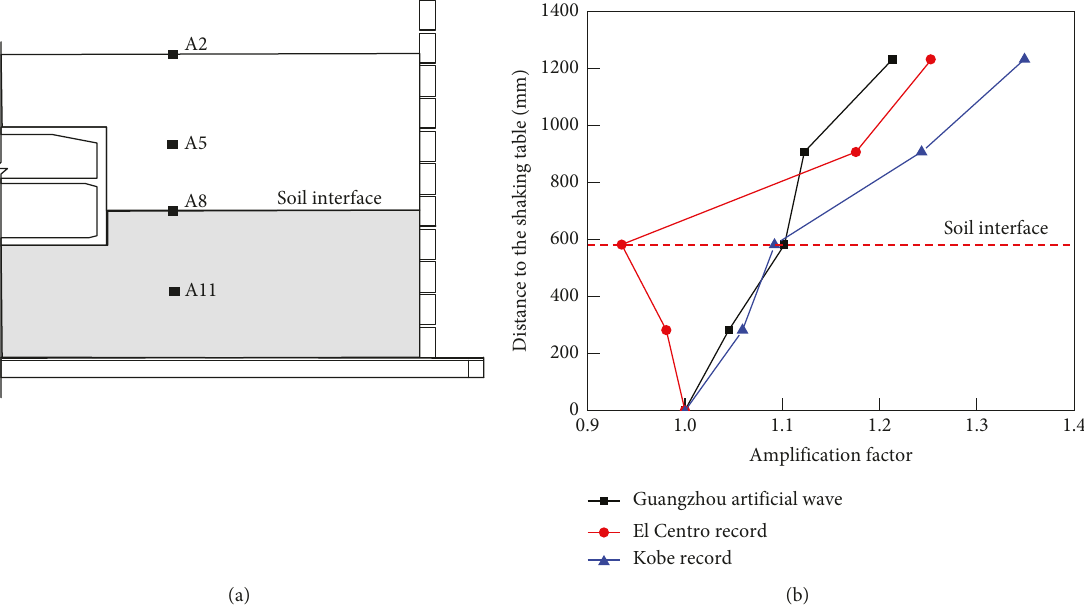
Figure 12: Peak acceleration amplification factor with the model soil depth in cases amplitude increased. However, the increment of the tensile Figure 18. For each component of the model structure, it is strain amplitude in the support region was larger than that in evident that the tensile strain amplitude in the support the midspan region, manifesting the irreversible de- region was larger than that in the midspan region. It is formation firstly occurring in the support region. Under the because that the support region of the large-span and col- input acceleration amplitude of 0.80 g, the largest tensile umn-free station bears much more force as the span in- strain amplitude of 130.2 με appeared in the support region creases greater than that of the conventional station, of the roof slab, followed by 100 με that appeared in the resulting in a larger tensile strain in the support region bottom support region of the lateral wall. In addition, the during the seismic wave. Nevertheless, the tensile strain tensile strain in the support region of the middle slab was amplitude in both the midspan region and the support also larger than 100 με . It is indicated that the support region almost linearly increased as the input acceleration